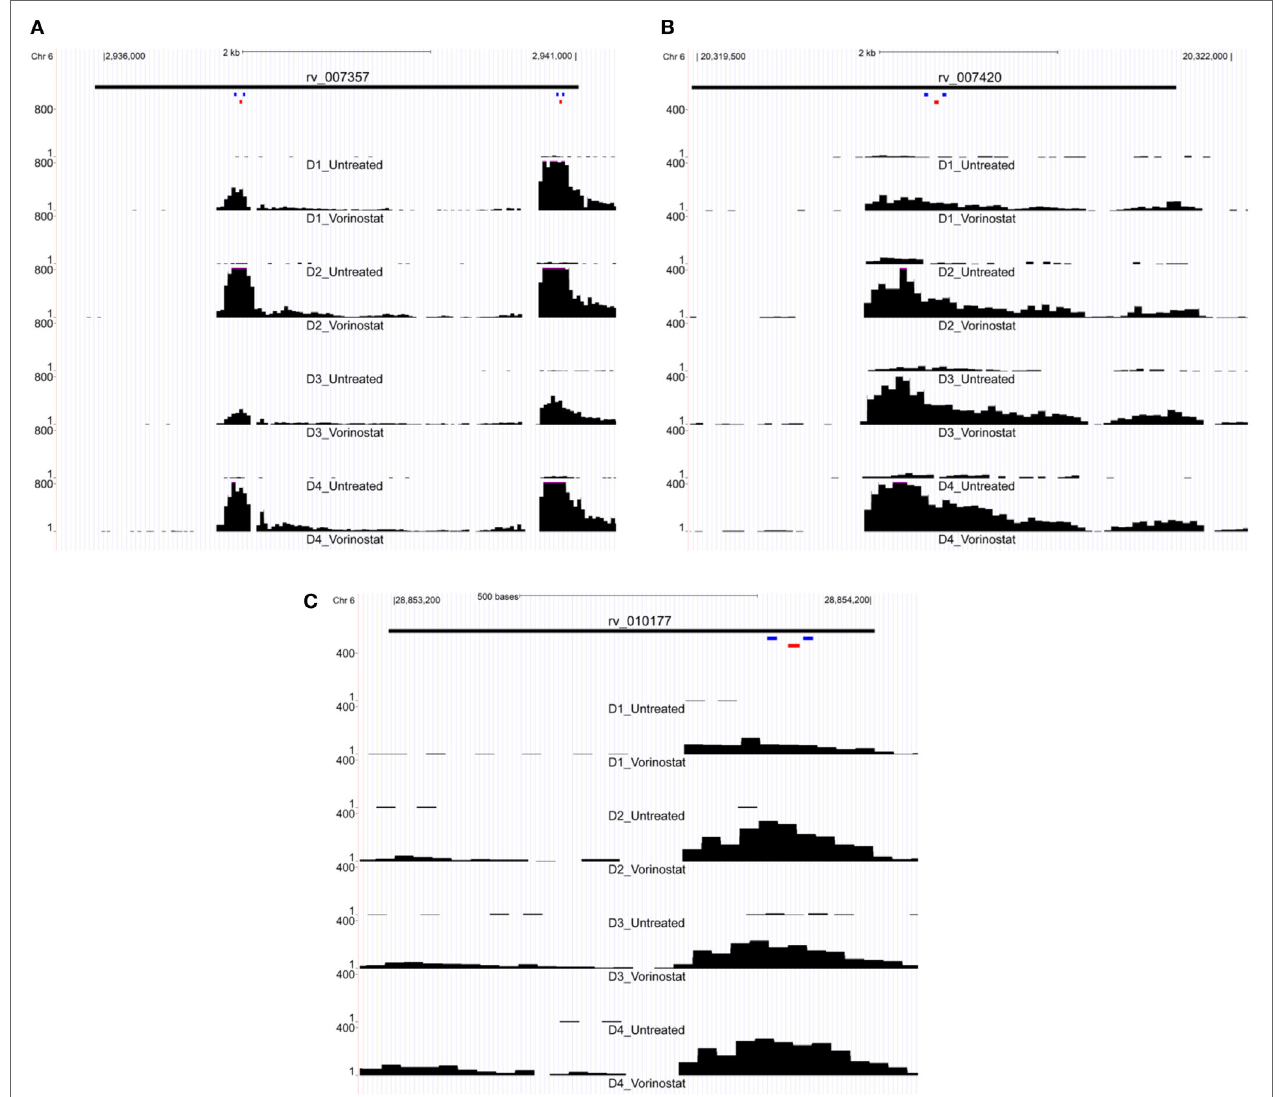
FigUre 2 | Expression of LTR12 elements visualized as read pile up using the UCSC genome browser. Reads from the total RNA-Seq experiment were mapped to the human genome and then uploaded to the UCSC genome browser for visualization of each LTR12 element: (a) rv_007357, (b) rv_007420, and (c) rv_010177. Read tracts are labeled with the donor and condition, e.g., D1 for Donor 1, Vorinostat for drug treated, and Untreated for the untreated control (i.e., dimethyl sulfoxide solvent alone). Chromosomal coordinates are depicted at the top of each figure, and the black bar below indicates the position of the LTR12 element. LTR12 elements are labeled with their “rv” designation from the Human Endogenous Retrovirus Database. The y -axis indicates the read level averaged over 40 bp, and the pink caps to black bars in the figure indicate reads whose numbers extended beyond the depicted scale. Small colored bars represent the position of primers (blue) and probes (red) from custom TaqMan assay used to assess the expression of LTR12 elements by droplet digital PCR. Two distinct TaqMan assays were targeted to rv_007357 (a) with a single assay against each of the remaining LTR12 elements (b,c)